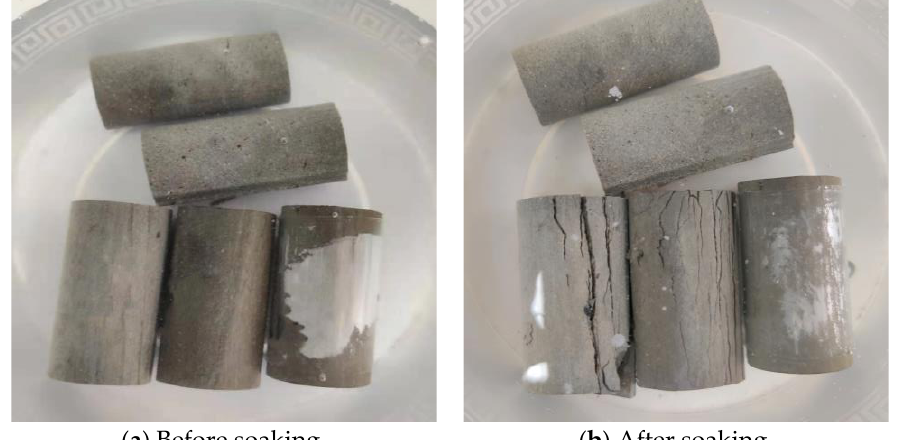
Figure 5. Soaking in water for 48 h.